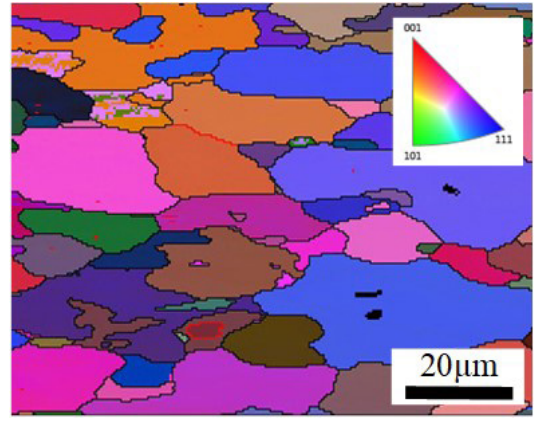
Figure 3. EBSD images of grains and boundaries of the base metal.